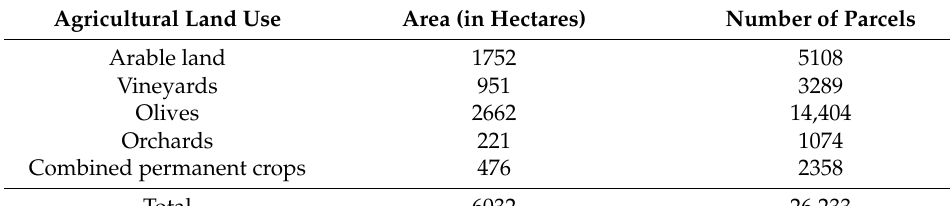
Table 5. Agricultural land considered as potentially available for biosolids application.